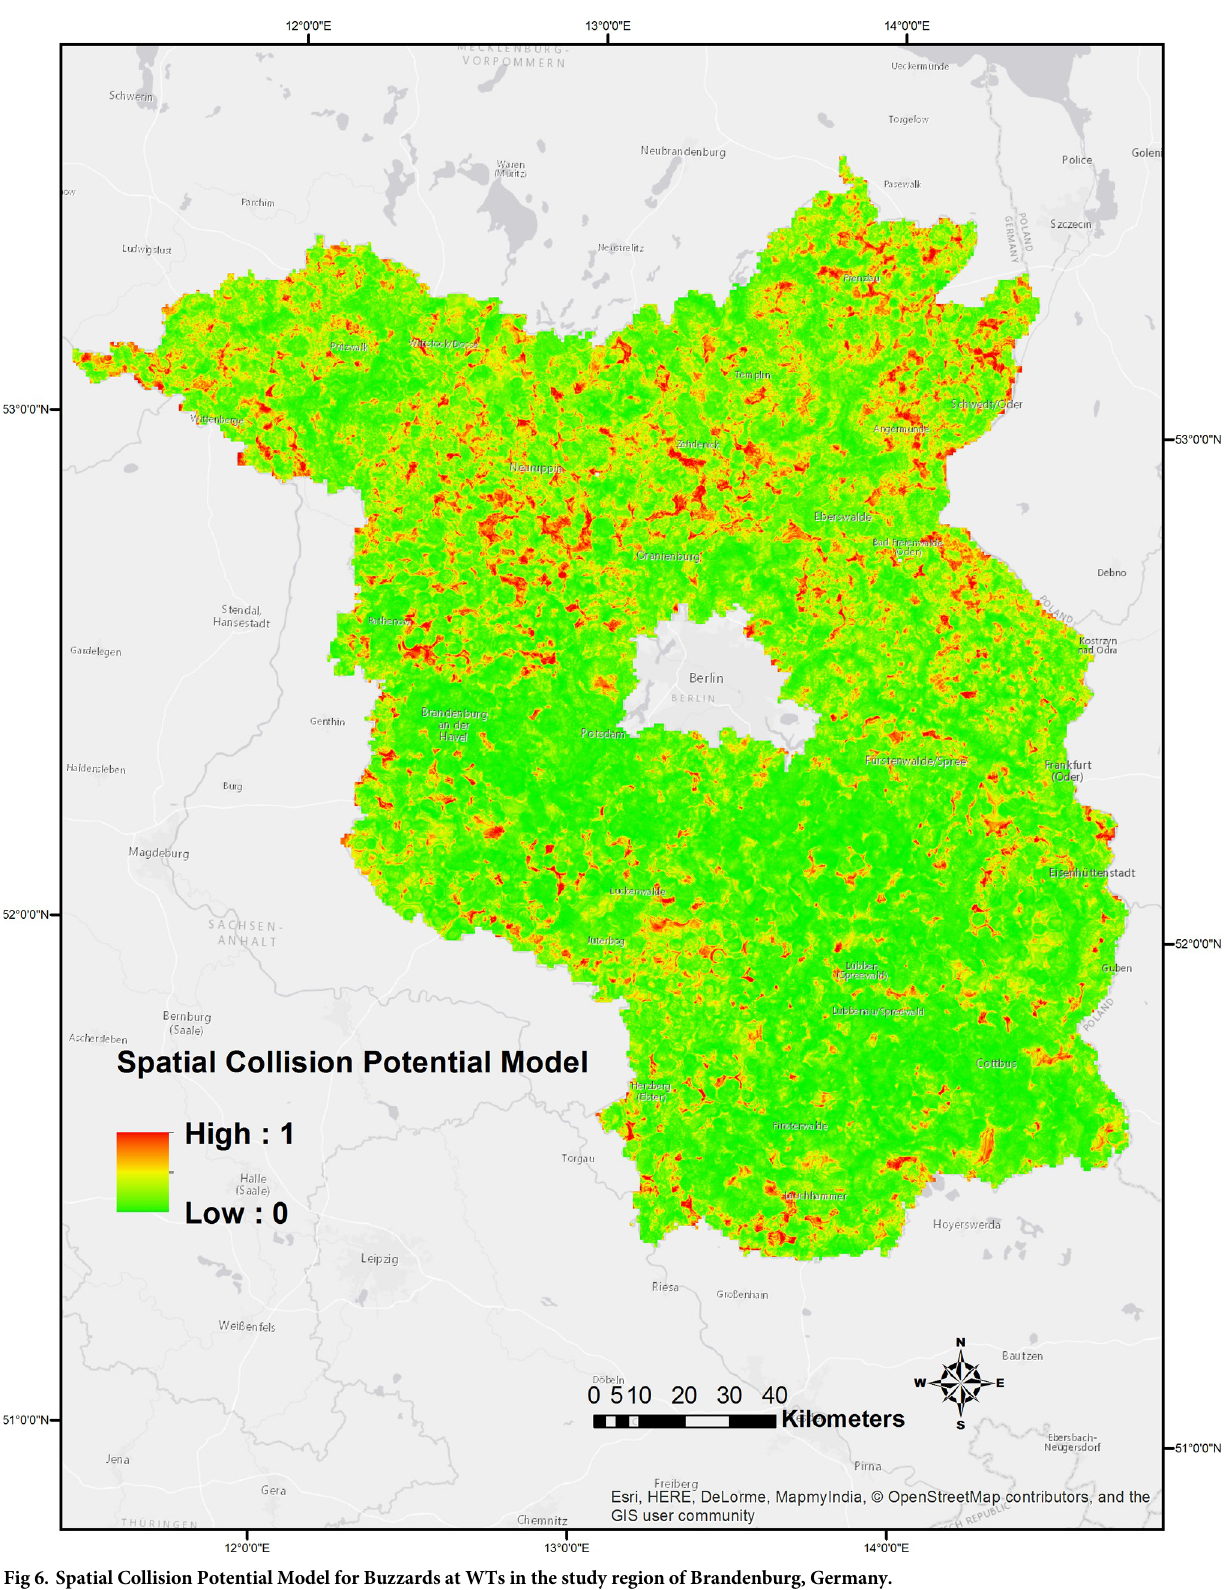
Fig 6. Spatial Collision Potential Model for Buzzards at WTs in the study region of Brandenburg, Germany.